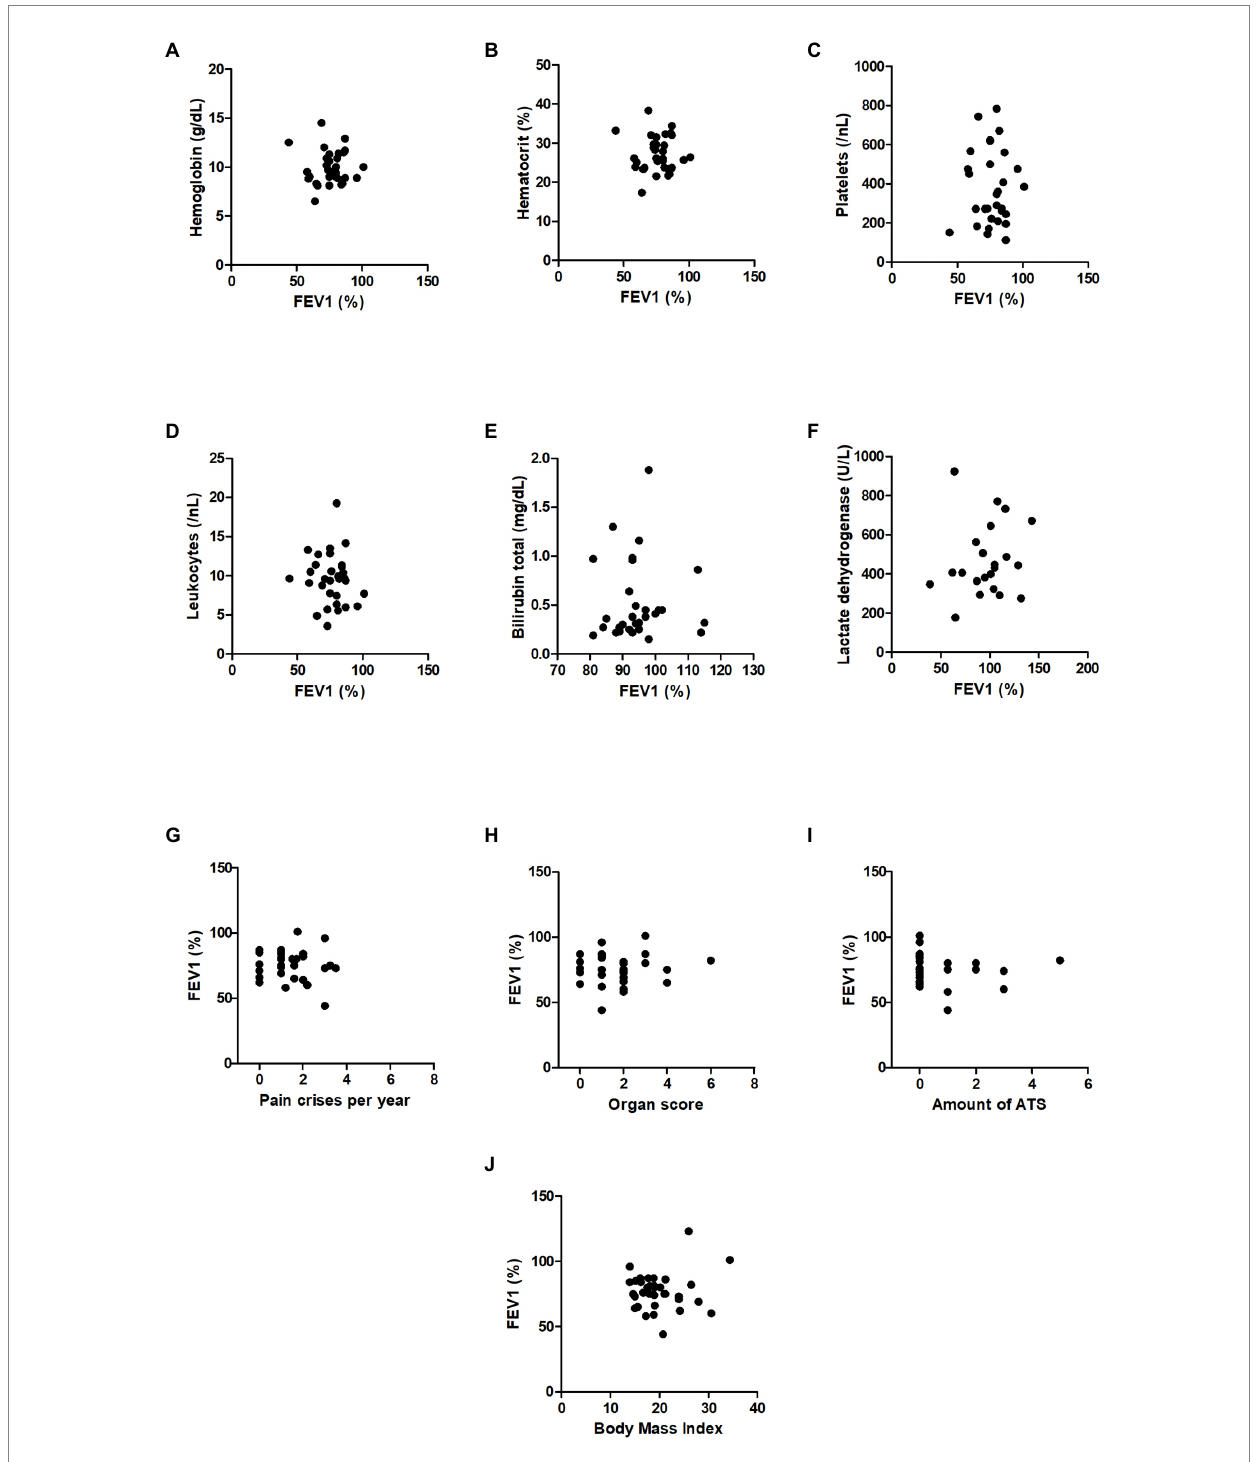
FIGURE 3 Correlations of blood parameters with FEV1 and correlations of FEV1 with disease activity parameters in SCD patients. (A) Serum levels of hemoglobin (g/dL), (B) hematocrit (%), (C) platelets (/nL), (D) leucocytes (/nL), (E) total bilirubin (mg/dL), (F) lactate dehydrogenase (U/L), (G) pain crises per year, (H) organ score, (I) amount of ATS, (J) body mass